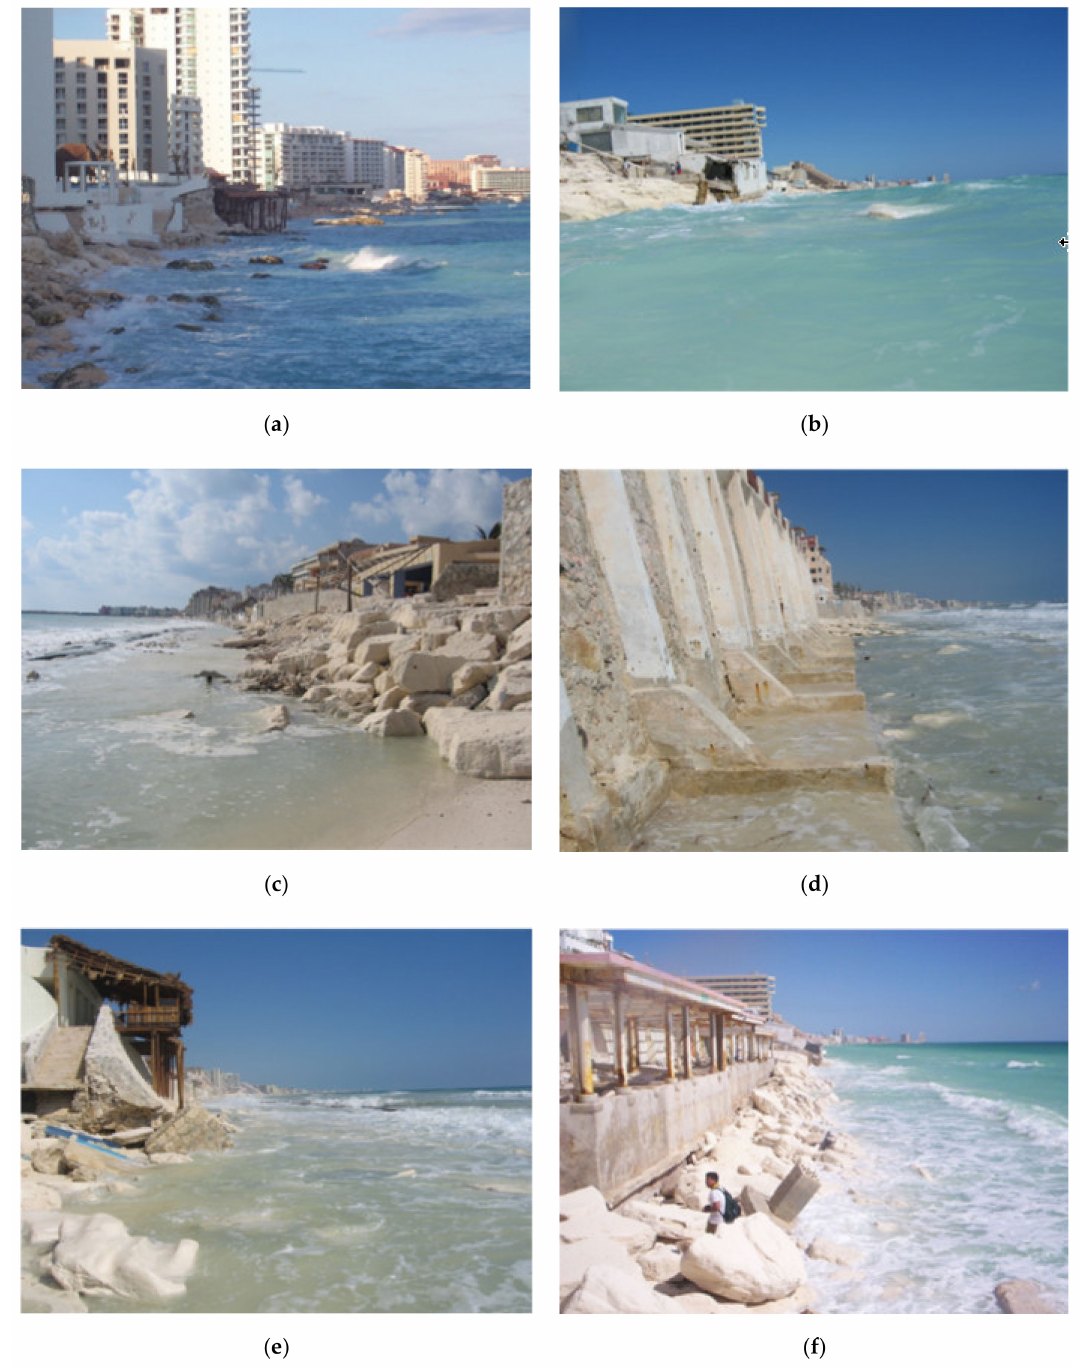
Figure 4. Examples of damage caused by Hurricane Wilma to the beach of Cancun in 2005. It can be seen that in front of many hotels the beach totally disappeared; only rocks were left behind (panels ( a ), ( c ) and ( f )), while in other places, waves were hitting the hotels walls and facilities directly (panels ( b ), ( d ) and ( e